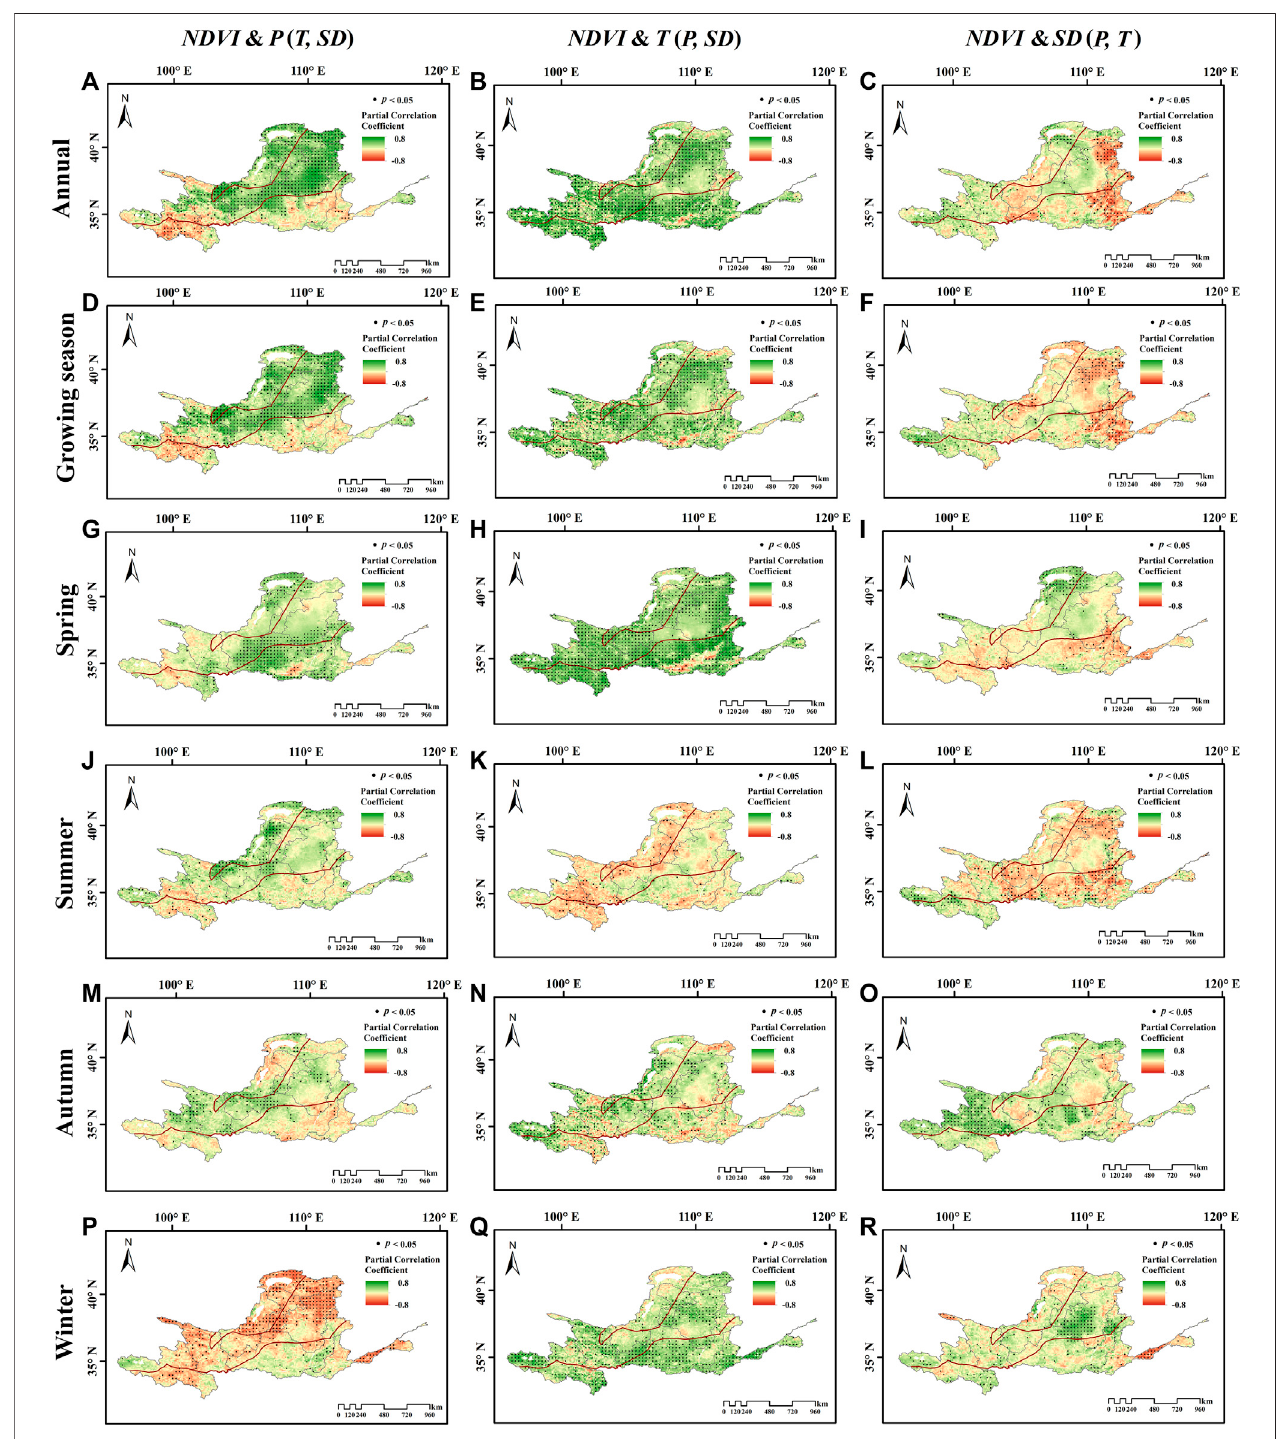
FIGURE 7 | Spatial distribution of partial correlation coef fi cients between NDVI and precipitation, temperature, and sunshine duration in the Yellow River basin in (A – C) annual; (D – F) growing season; (G – I) spring; (J – L) summer; (M – O) autumn; (P – R) winter, respectively. The black dots represent partial correlation coef fi cients at the signi fi cance level of p <